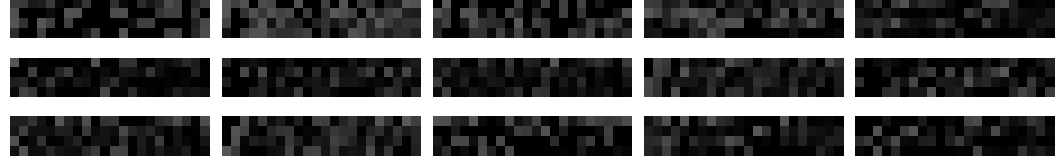
Figure 23. An example of fifteen processed image formed in the third step.